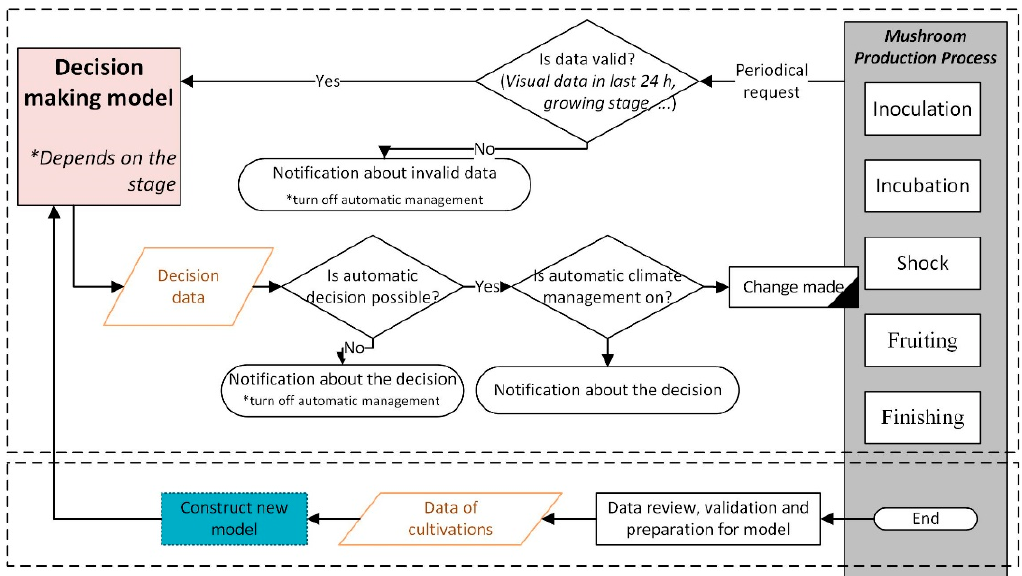
Figure 9. Generalized scheme of climate management process.